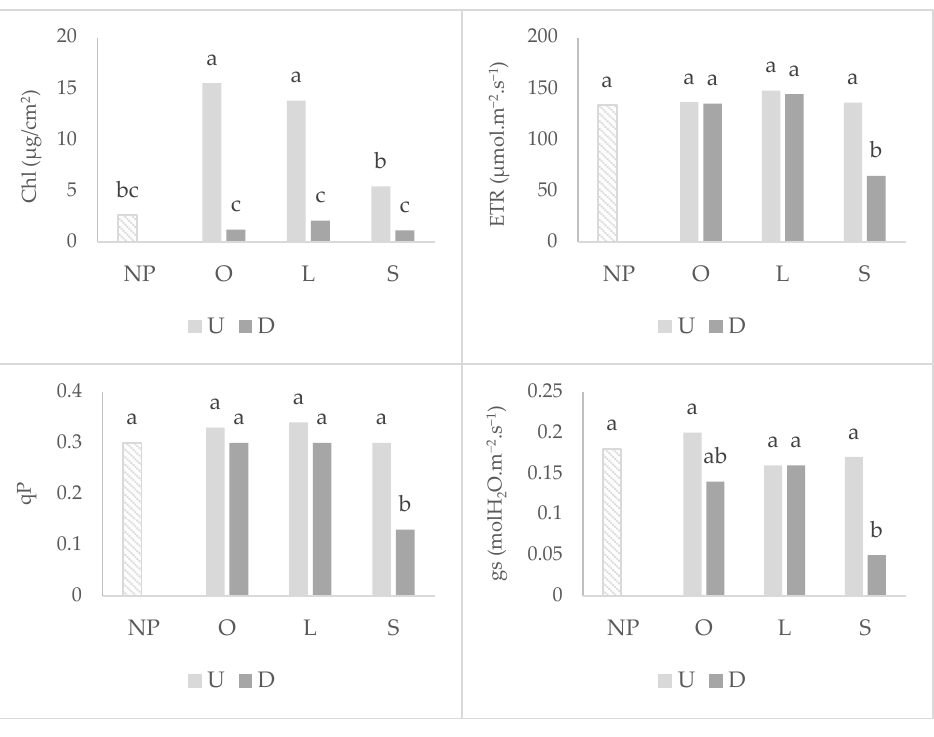
Figure 3. Graphs of interactions between previous plant type and soil disturbance in wheat photosynthetic parameters: chlorophyll content (Chl), electron transfer rate (ETR), photochemical quenching (qP) and stomatal conductance to water vapor (gs). NP: wheat that grew with no previous plants; O: wheat that grew after O. compressus ; L: wheat that grew after L. rigidum ; S: wheat that grew after S. gallica ; U: soil undisturbed and D: soil disturbed. Values sharing different letters indicate significant differences between treatments at the 5% level (Tukey’s t -test). Table 1. Effect of previous type of plant and soil disturbance on wheat photosynthetic parameters: maximum quantum efficiency of PSII (Fv/Fm) and photosynthetic rate (A). Fv/Fm